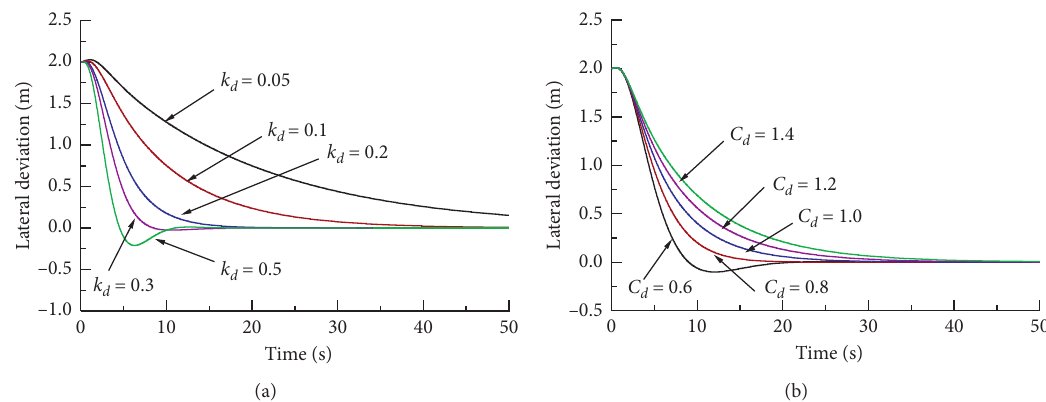
Figure 8: Comparisons of convergence rate of the lateral deviation with various control parameters: effects of (a) k Figure 16(a), the vehicle moves towards the planned path. After the vehicle is close to point A on the path, it can better follow the path against with curvature variations of the path. The maximum lateral deviation from the path is about 2.0 cm (see Figure 16(d)). Moreover, the vehicle controlled is capable of tracking the velocity profiles within about